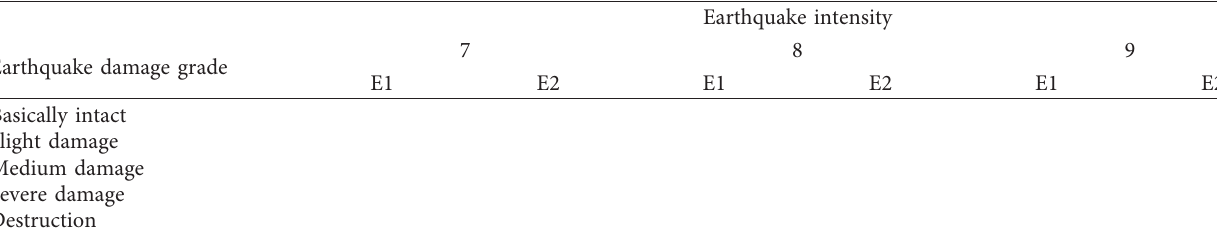
Table 6: Seismic damage prediction matrix.